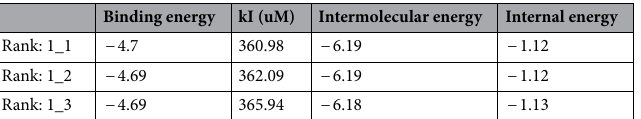
Table 1. Docking properties for the best three docked structure. Energies are in kcal mol −1 .